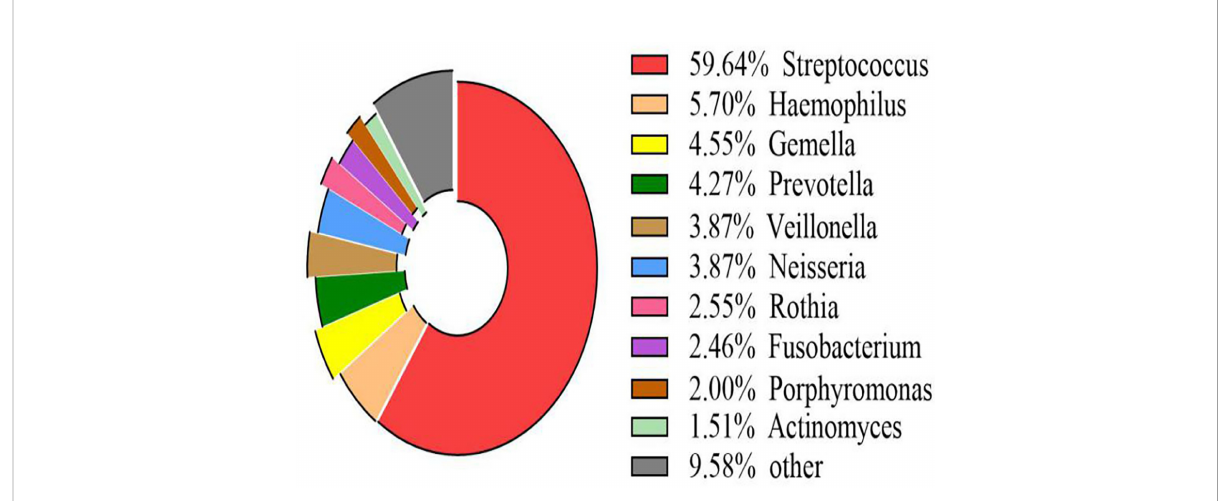
FIGURE 4 Scale map of the top 10 genera in abundance (all samples) The map displayed the proportion of several kinds of genera with richer contents